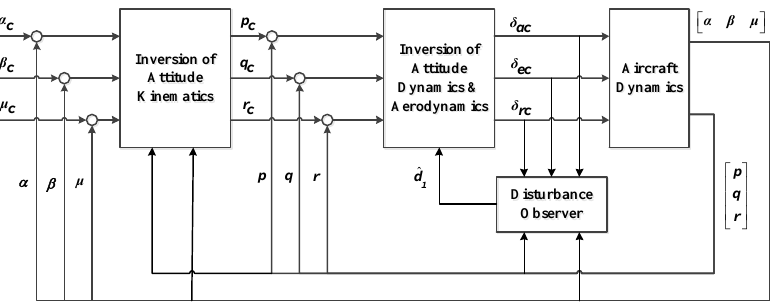
Figure 4. Disturbance observer-enhanced NDI controller.